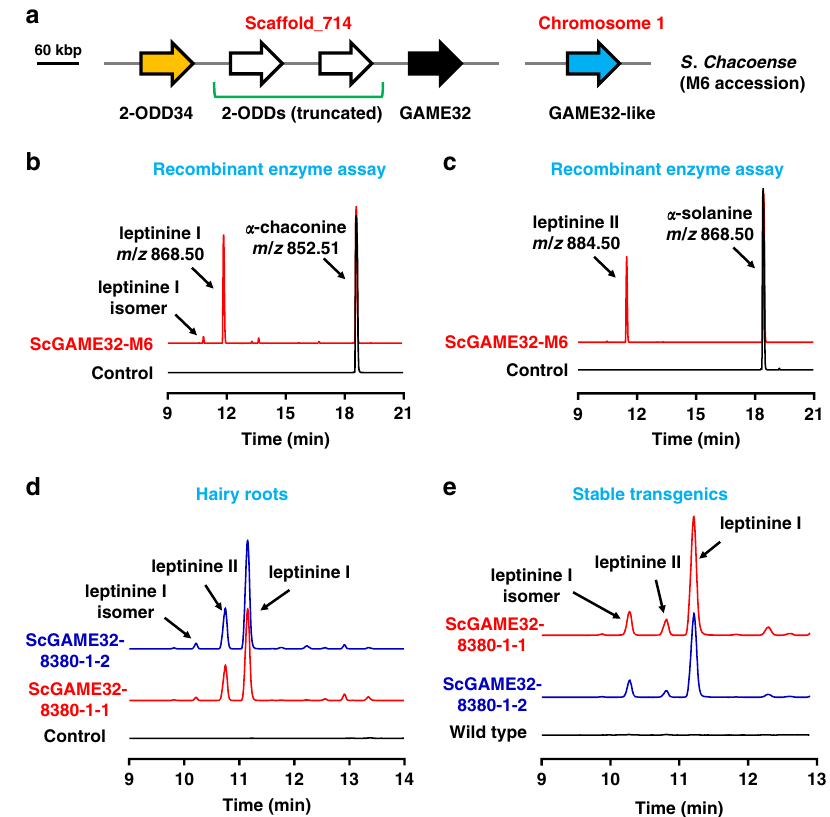
Fig. 5 GAME32 hydroxylates the main potato SGAs to form CPB resistance-associated leptinines. a Schematic presentation of the 2-ODD family members GAME32 (black), GAME32-like (blue), and 2-ODD34 (yellow) genes in the S. chacoense ( Sc ) genome (accession M6). Truncated 2-ODDs are shown in white block arrows. b , c The recombinant ScGAME32-M6 enzyme converts α -chaconine ( b ) and α -solanine ( c ) to leptinine I (plus isomer) and leptinine II, respectively. Red: reaction assay with the respective substrate and the recombinant S. chacoense -M6 GAME32 protein (produced in E. coli ); black: control reaction with the respective substrate and the protein extracts of empty vector-transformed E. coli . Mass to charge ( m / z ) is shown for all substrates and assay products. MS-MS analysis and identi fi cation of leptinines metabolites are provided in Supplementary Figs. 29 – 32. d De novo production of